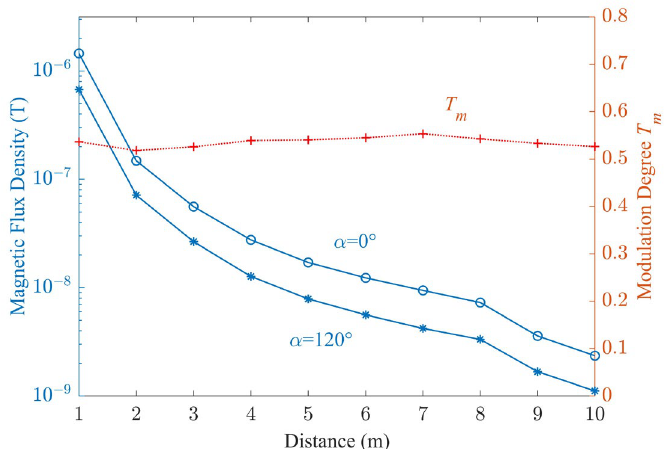
Figure 7. The distribution of magnetic flux density B and modulation depth T m .